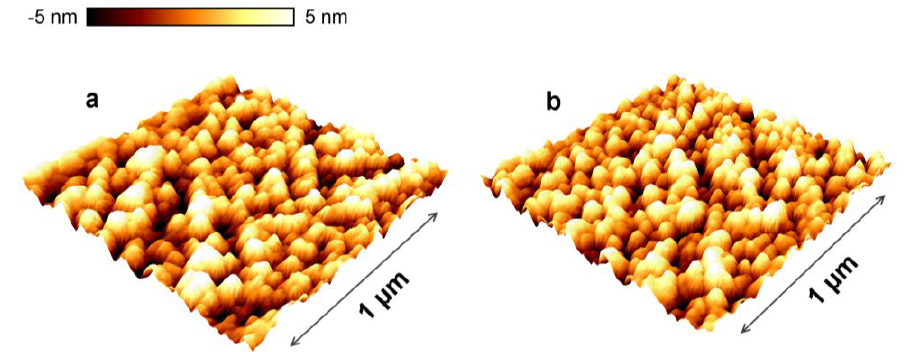
Figure 3. Atomic force microscopy (AFM) micrographs for the films with ( a ) 2% and ( b ) 25% <001> orientation.